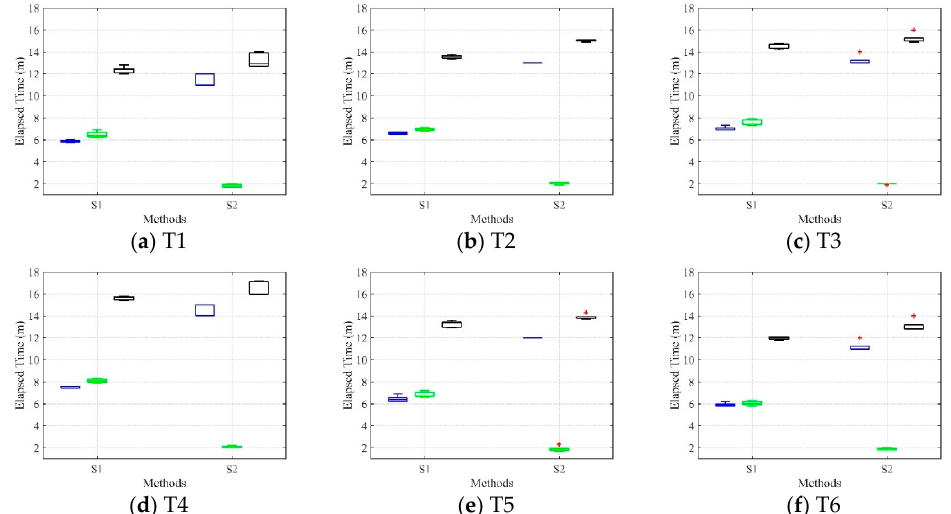
Figure 10. Execution time of the first, the second, and the total segmentation stage (indicated as blue, green, and black) for T1 to T6 using the SLIC algorithm with eight executors. The red plus indicates the outliers.